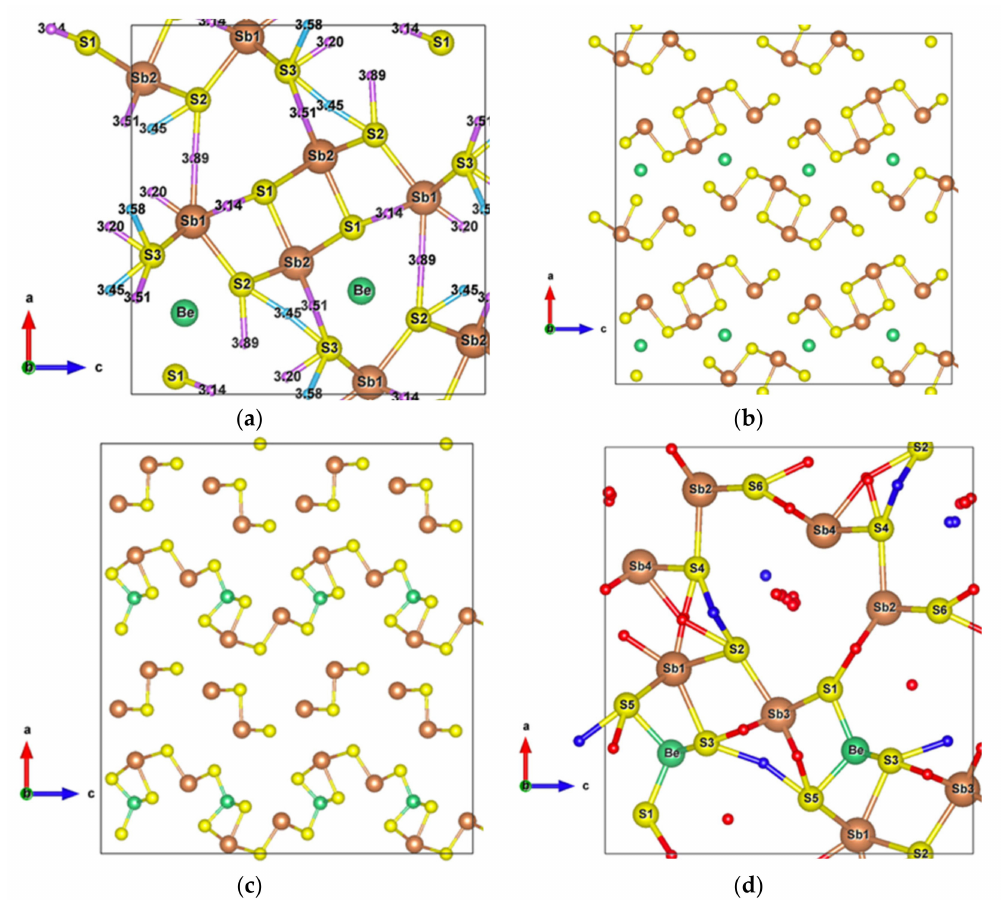
Figure 5. ( a ) Sb 2 S 3 unit cell with inserted Be metal atoms along the z -axis; ( b ) Sb 2 S 3 supercell with Be atoms; ( c ) Sb 2 S 3 supercell with Be atoms after structural relaxation; ( d ) Relaxed Sb 2 S 3 unit cell with all interatomic interactions. Small red balls are BCPs of Sb–S interactions and blue balls are BCPs of S–S secondary neighbors